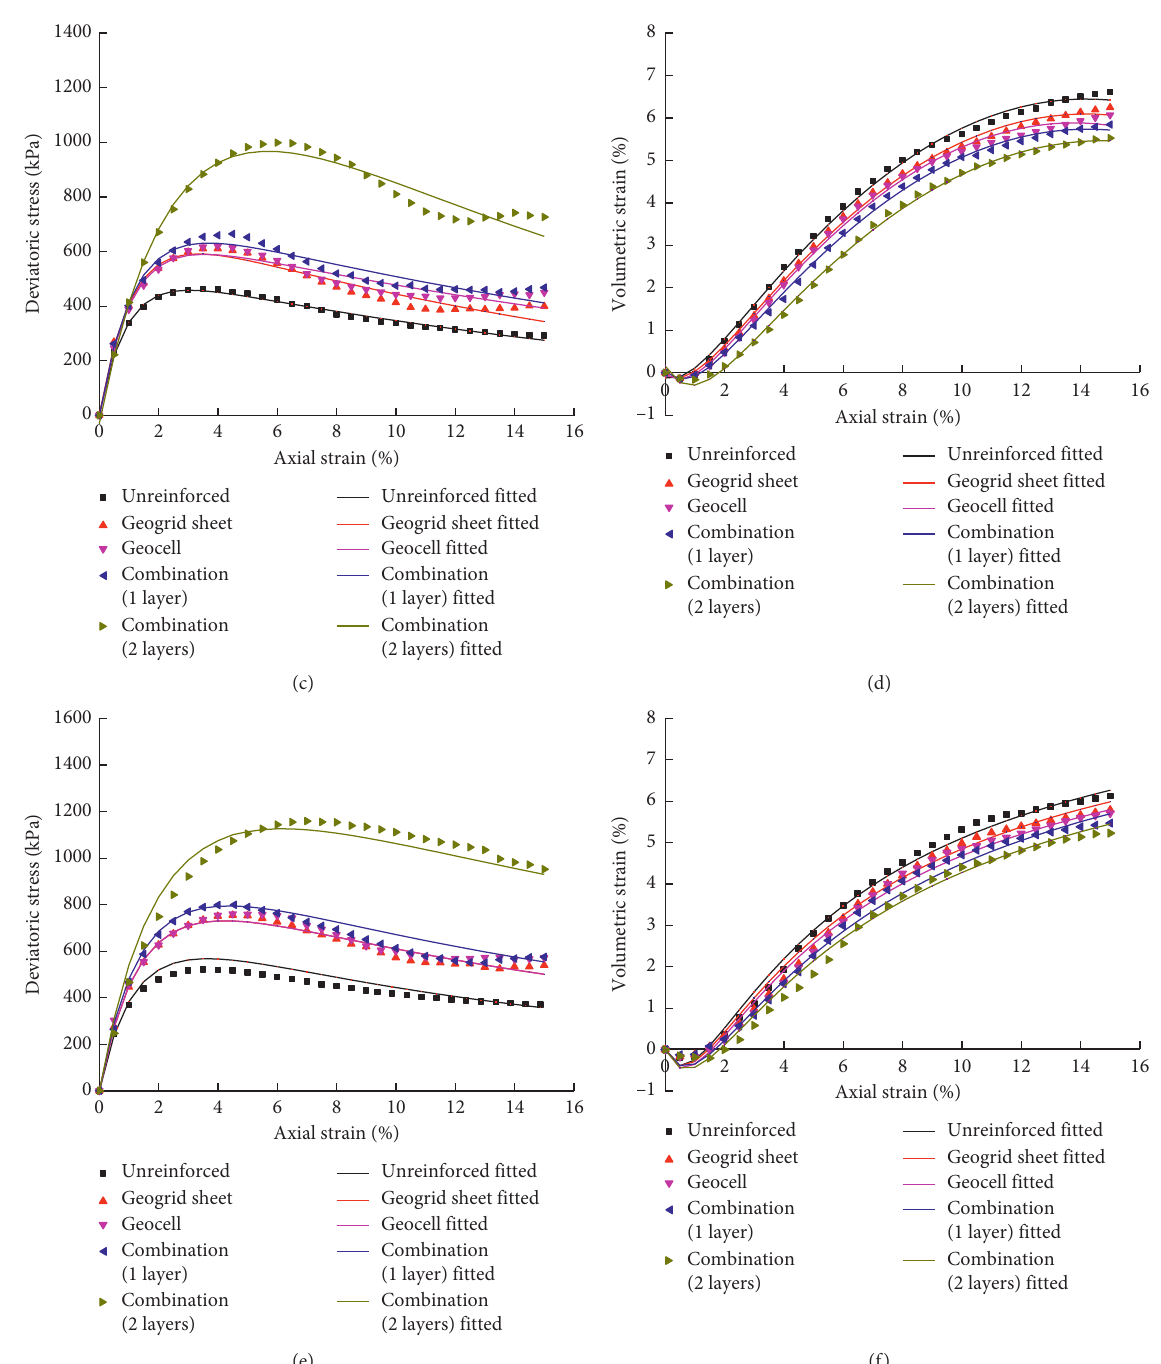
Figure 7: Comparison of tested and modelled ε (d) σ 3 � 75 kPa, (e) σ 3 � 100 kPa, and (f) σ 3 � 100